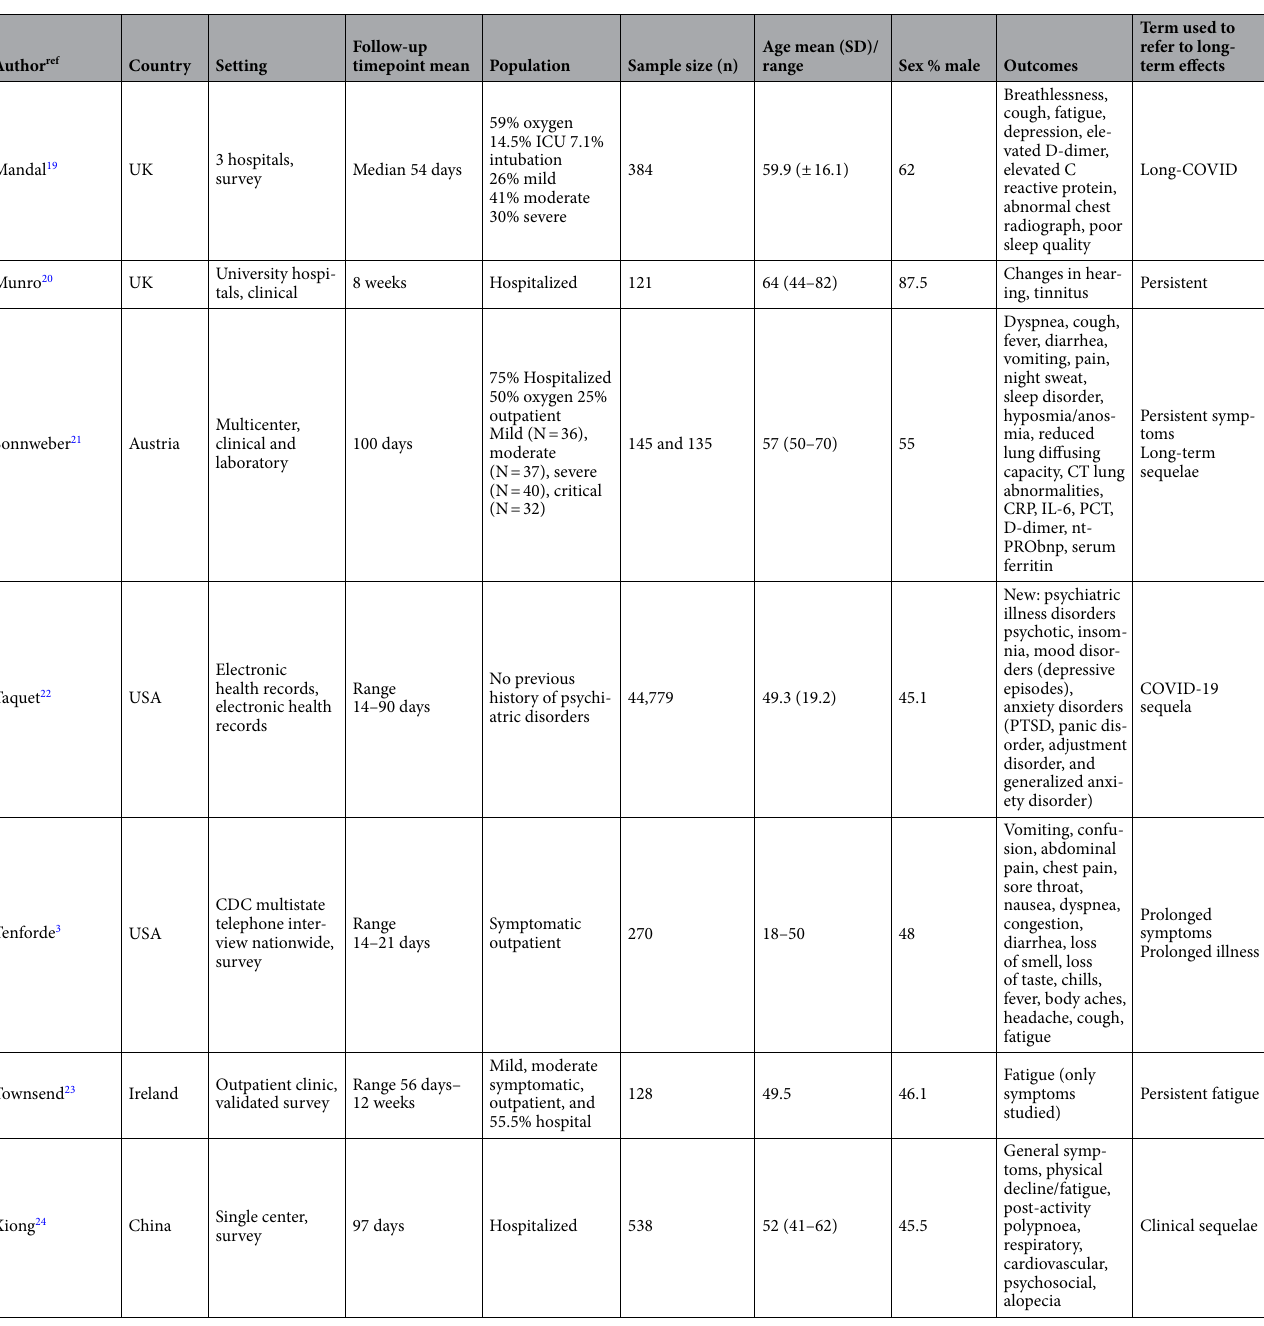
Table 1. Characteristics of all included studies. NR not